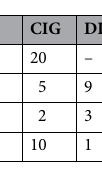
Table 3. EoT response in agreement with CT-based